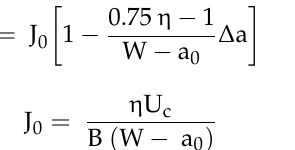
Figure 3. Crack propagation curve (crack length Δ a marked as dots) for evaluating physical crack initiation with three characteristic stages: stage I (crack tip blunting), stage II (non-stationary stable crack growth) and stage III (stable crack growth) . For the measured specimens in this study, no data points at a very low testing time were available (stage I), hence, the initiation time had to be verified with a slightly modified procedure (Figure 4a). The initiation time (t ini ) was determined as the intersection between the linear data fit of stage III and the x-axis. Afterwards, the J-integral was calculated using the area under the load displacement curve, U, up to the displacement at t ini . The J-integral was calculated according to the recommended formula from the ESIS TC-4 procedure [10]: J (cid:2919)(cid:2924)(cid:2919) =